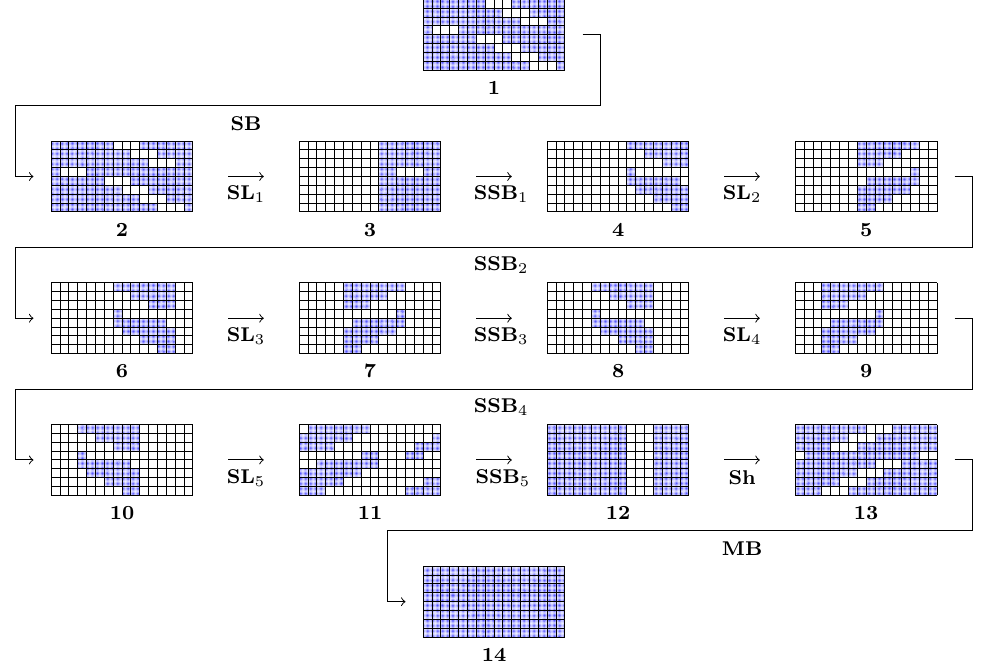
Figure 14: The 11 − round truncated differential path over Q 1024 with